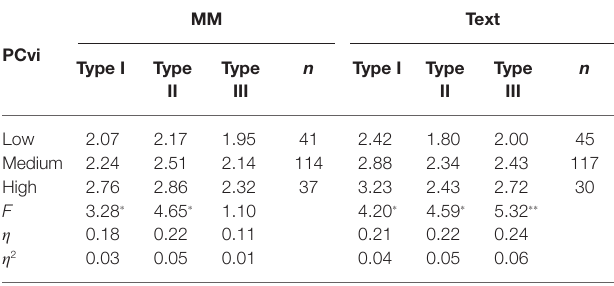
TABLE 8 | Mean values (non-relative values) for learning outcomes for visual progressive capacity (PCvi) for the three instruments in multimedia (MM). MM PCvi